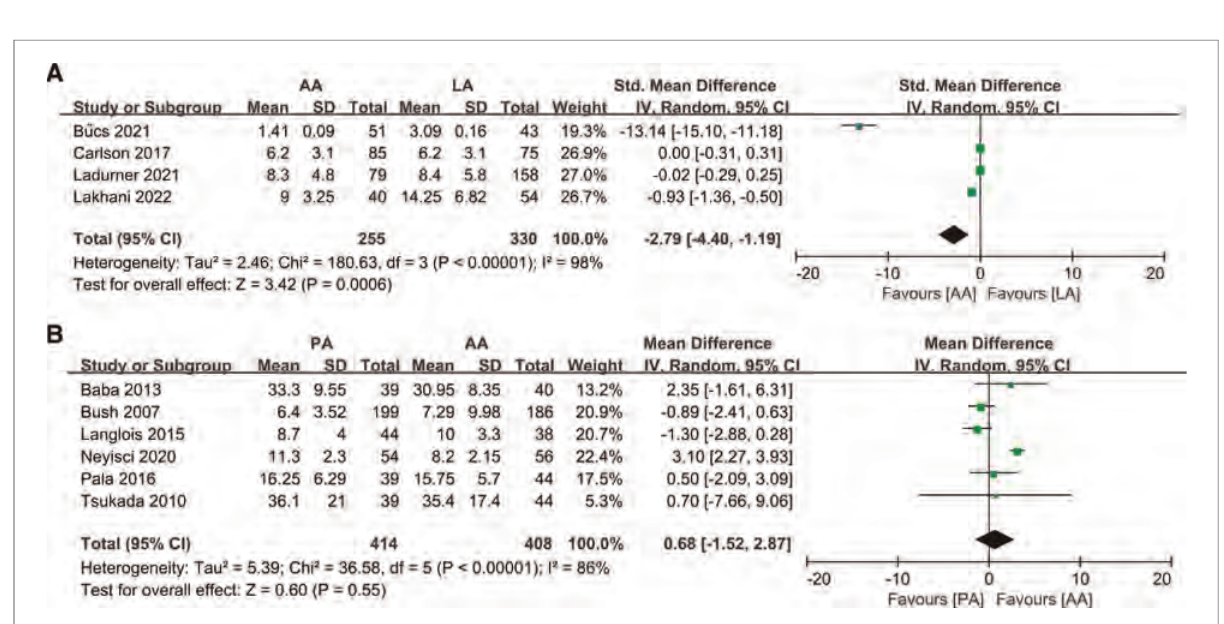
FIGURE 3 Forest plot comparison of length of hospitalization. ( A ) Anterior approach and lateral approach, ( B ) Anterior approach and posterior